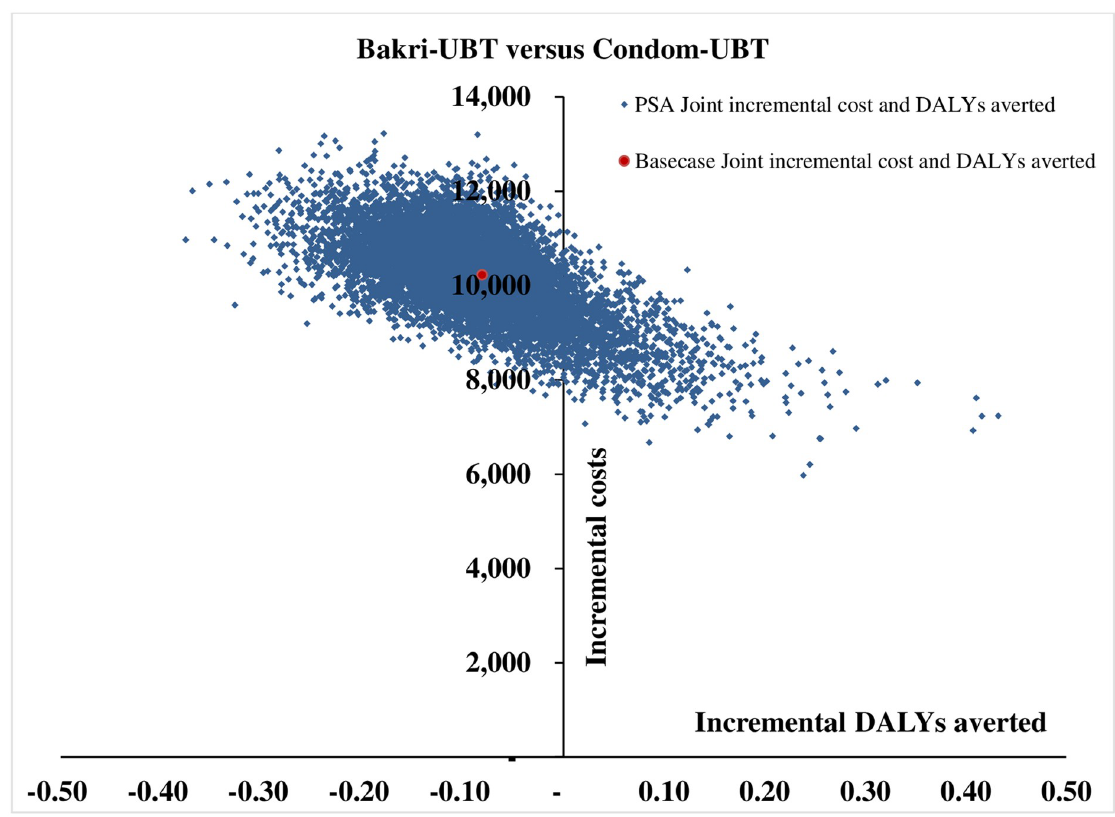
Fig 5. Probabilistic sensitivity analysis results with 10,000 Monte Carlo simulations for Bakri-UBT versus condom-UBT comparison.